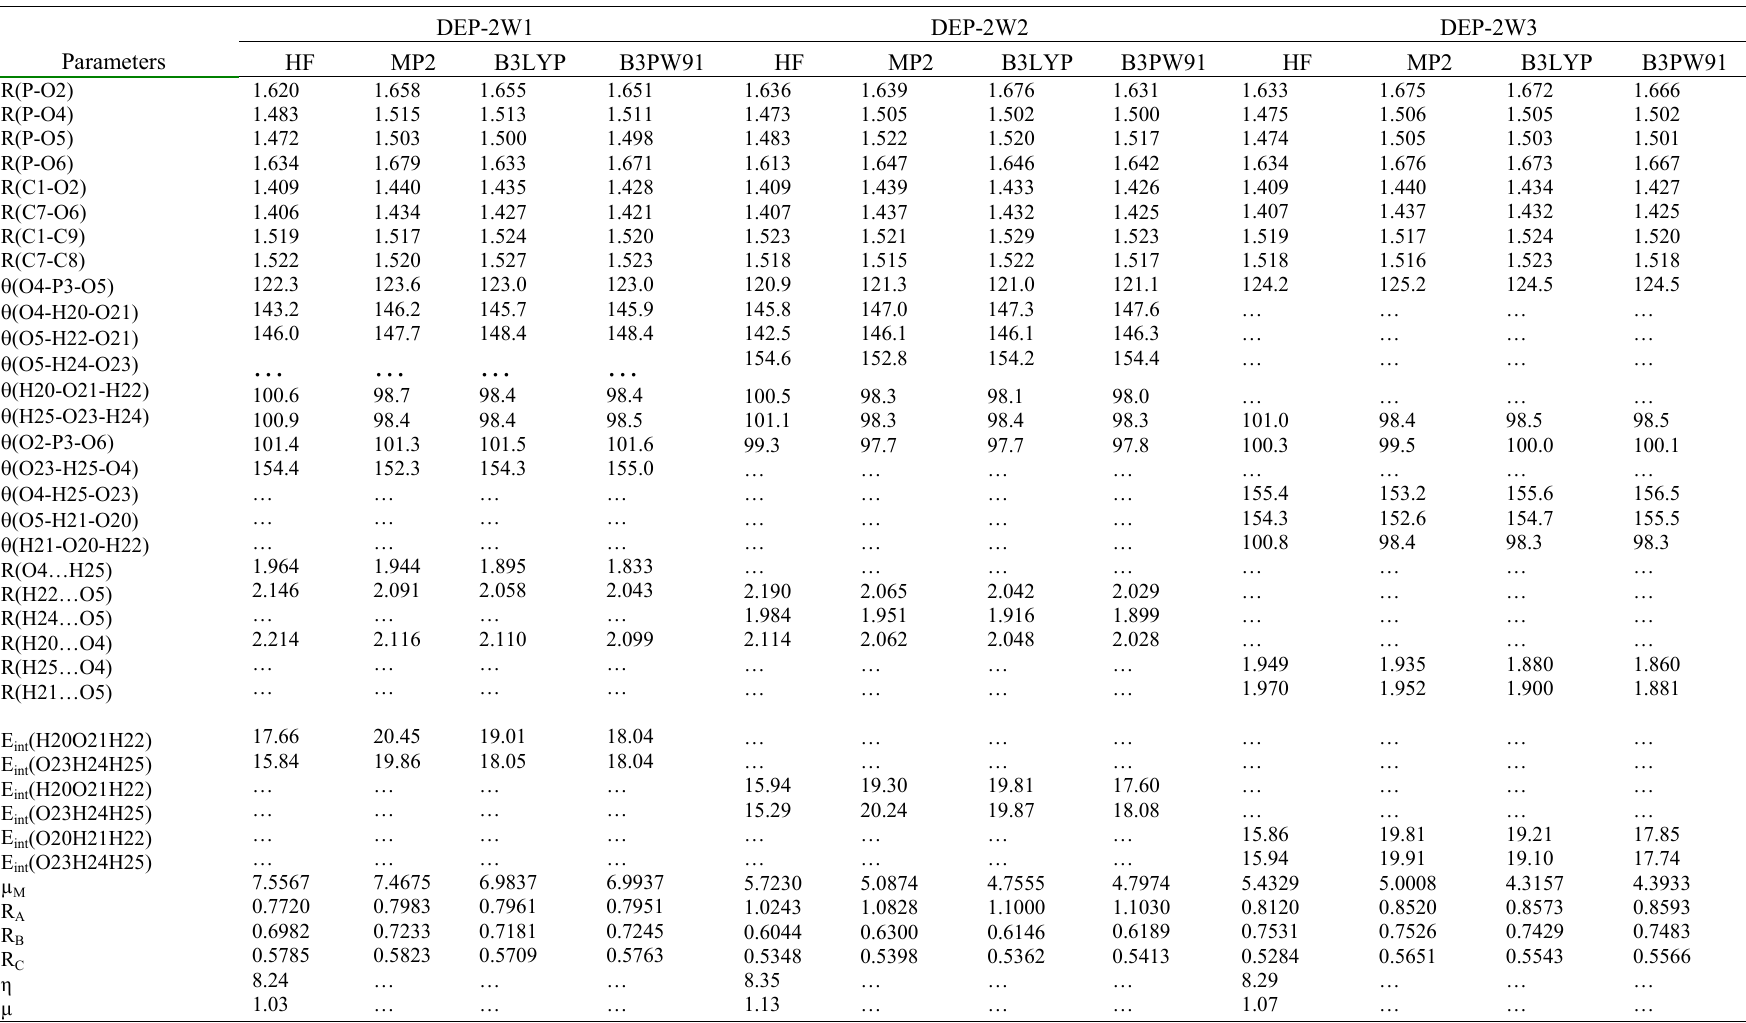
, R , R (in GHz), dipole moment µ A B C